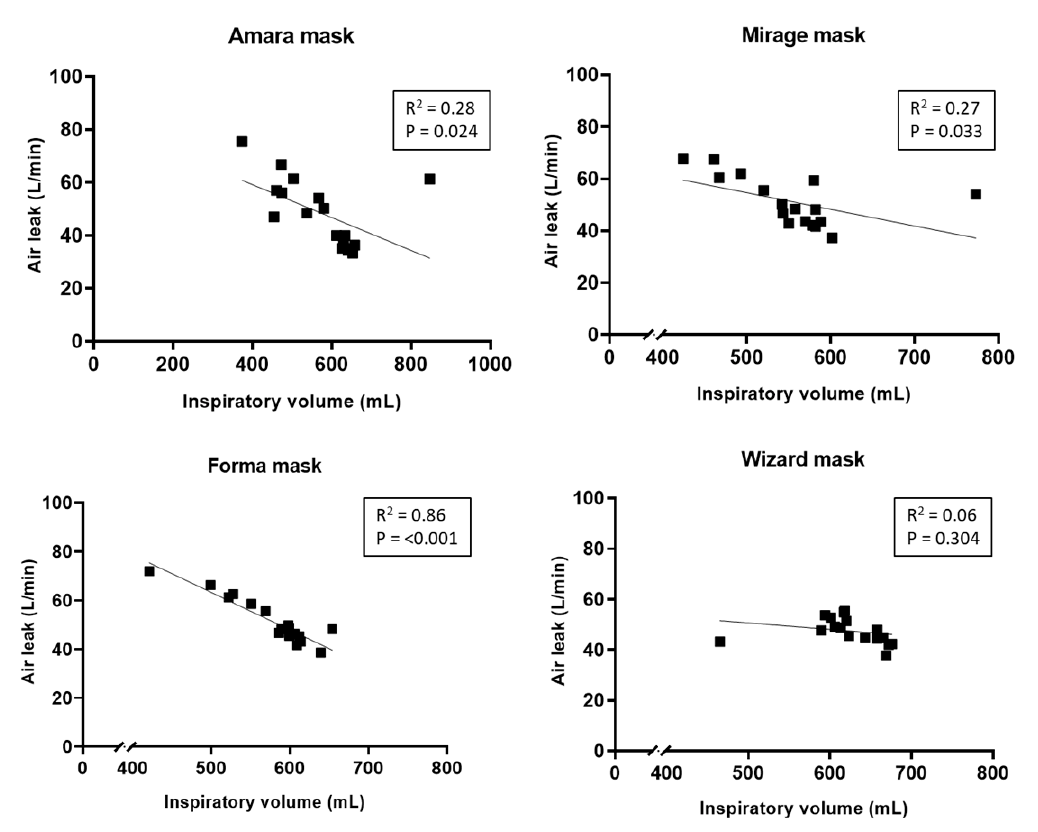
Figure 3. Correlations between air leak and inspiratory volume among the four masks.